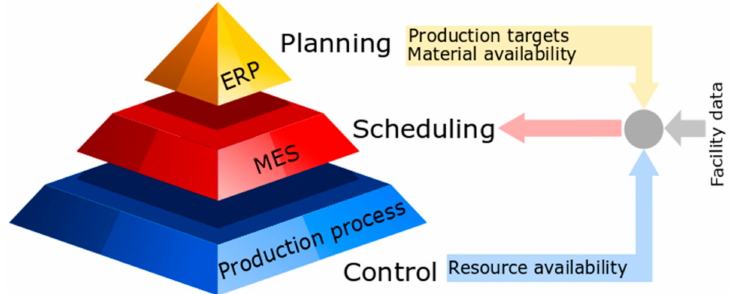
Figure 2. Information flow towards scheduling